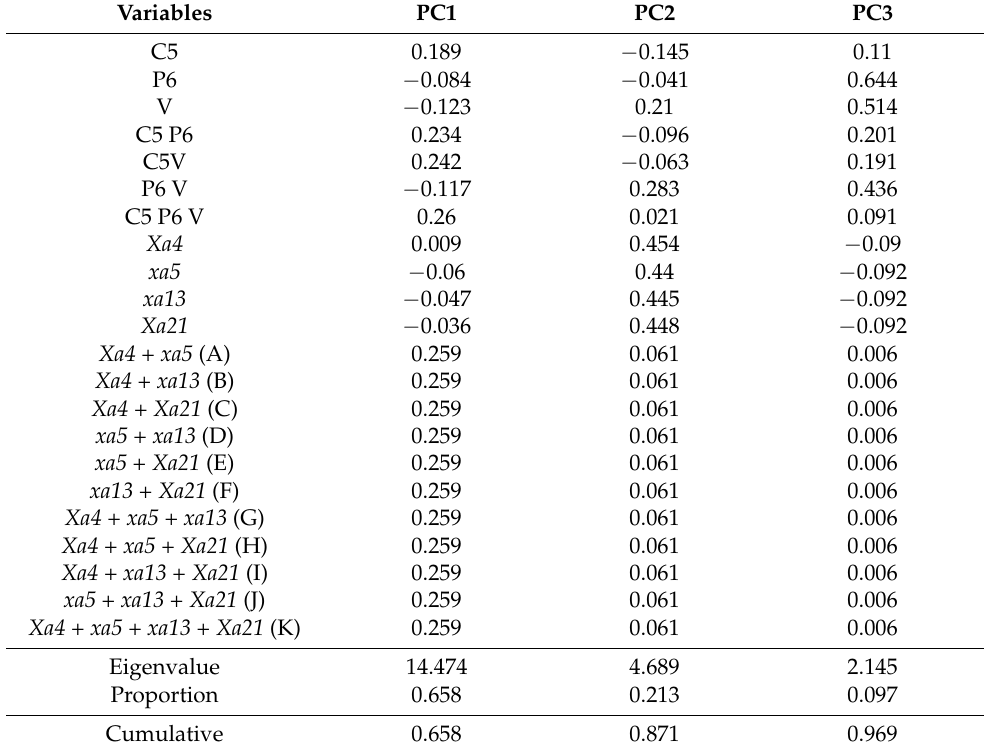
Table 5. Component loadings and mean principal component (PC) scores, showing (1) the association between resistant, moderately resistant, moderately susceptible, susceptible, and highly susceptible groups, along with their BB resistance gene(s) individually or in pyramiding conditions; and (2) the disease reaction in BB races (individually or in combinations) as determined using the principal component analysis. The combinations of resistance genes are grouped alphabetically for easier representation in Figure